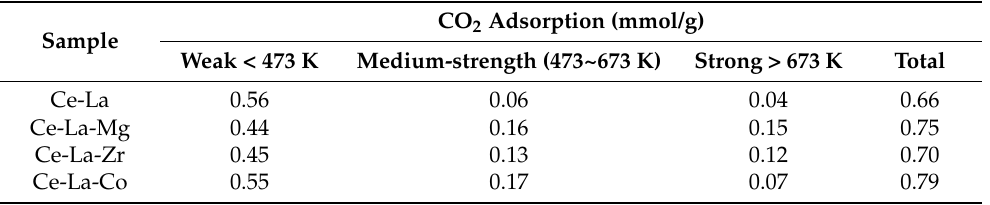
Table 3. Adsorption capacity of CO 2 of cerium lanthanum solid